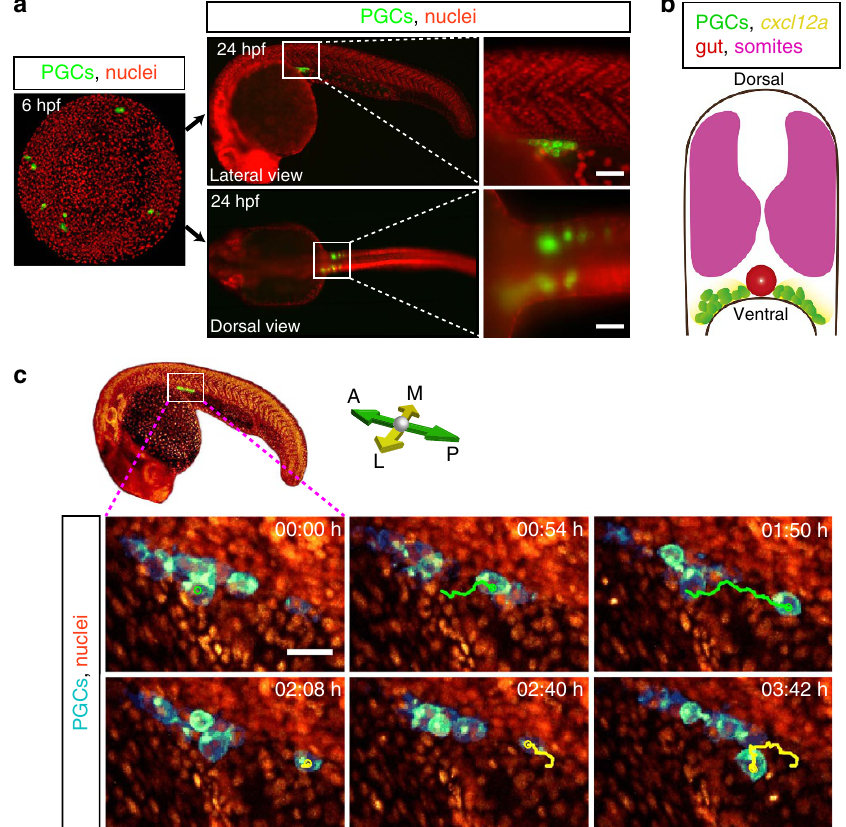
Figure 1 | PGCs are motile at the gonad region. ( a ) PGCs migrate from four different positions in the embryo (green clusters in 6hpf image) towards the developing gonads to form two separate cell clusters by end of the first day of embryonic development (lateral and dorsal views). Insets display higher magnification of the gonad region (white boxes). Scale bars represent 50 m m. ( b ) A schematic cross-section of a 1-day-old zebrafish embryo showing the somites (magenta), the two separate PGC clusters (green cells) located on either side of the developing gut (red structure), as well as the expression of cxcl12a at this stage (yellow). ( c ) Snapshots from a time-lapse movie (Supplementary Movie 2) showing a lateral view of a PGC cluster starting at 24hpf In the first three time points posterior migration of a PGC is highlighted (green track) and lateral–medial migration of the same PGC is presented in the following panels (yellow track). Scale bar, 25 m